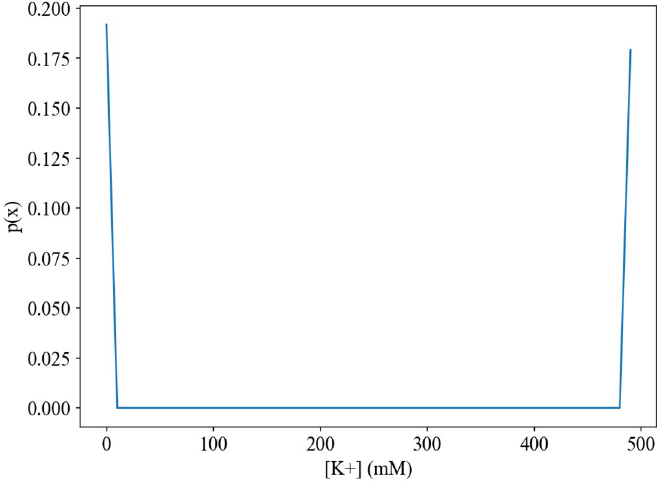
Fig 4. Optimal p(x) input distribution. The optimal input would favor the K+ extracellular concentrations at the extremes of the concentration domain. This is expected, as these concentrations favor high overall entropy of output but low conditional entropy of output given